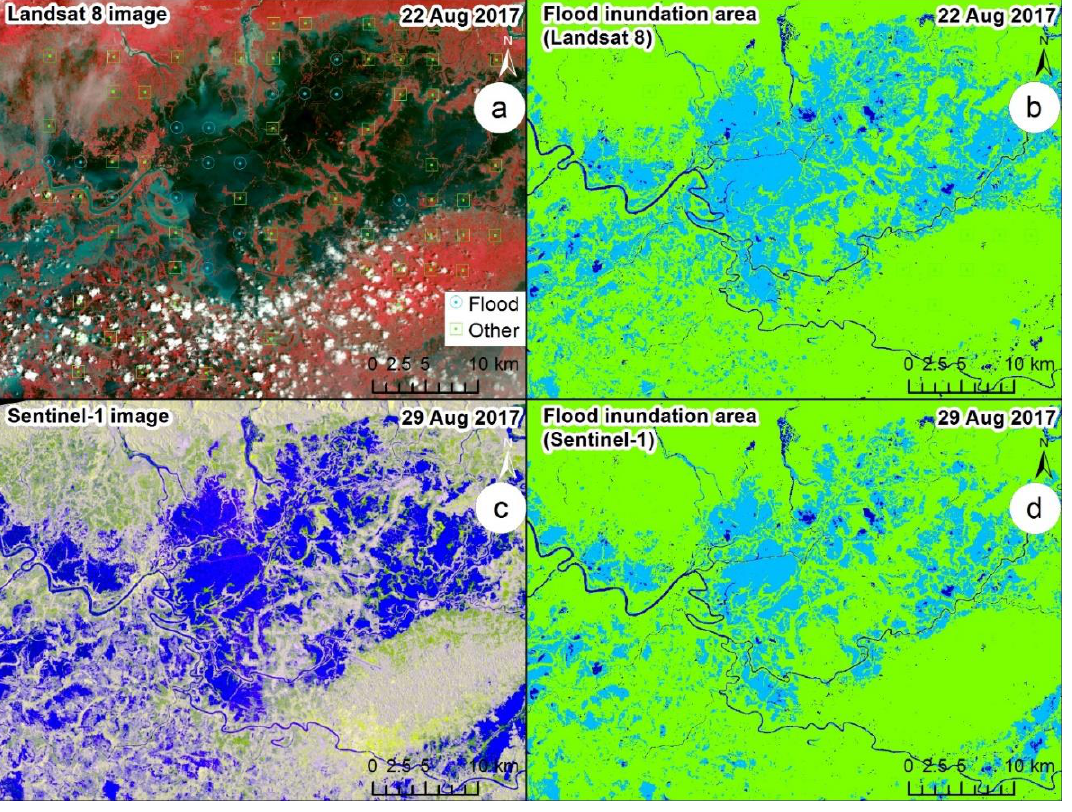
Figure 4. Comparison of optical data and synthetic aperture radar—(SAR) based flood inundation: ( a ) False color composite Landsat-8 image from 22 August 2017; ( b ) classification result based on Landsat-8 (dark blue: Perennial water; light blue: Flood inundation areas; green: Other areas); ( c ) false color composite Sentinel-1 image from 29 August 2017, showing water bodies in blue; ( d ) classification result based on Sentinel-1 data (same color assignment).